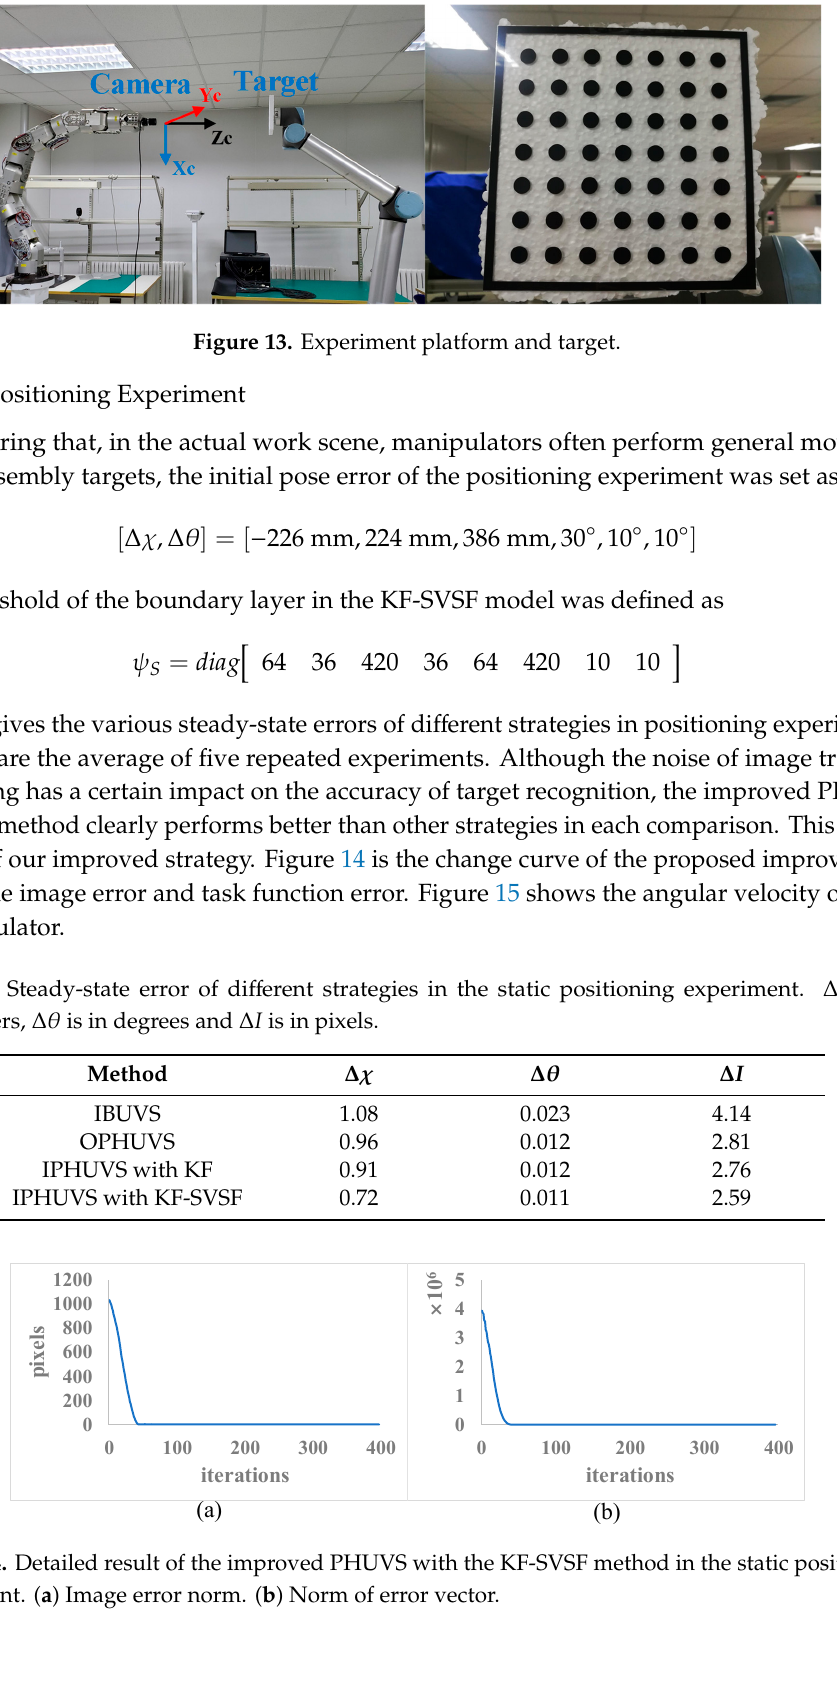
Figure 15. Joint velocities of the improved PHUVS with the KF-SVSF method in the static positioning experiment. 5.2.2. Dynamic Tracking Experiment In the dynamic tracking experiment, the target was fixed to the end-effector of a universal robot and taken to move along different paths. To ensure reliability, both complex planar and 3-D paths were tested. The planar and 3D paths of the target were set as (